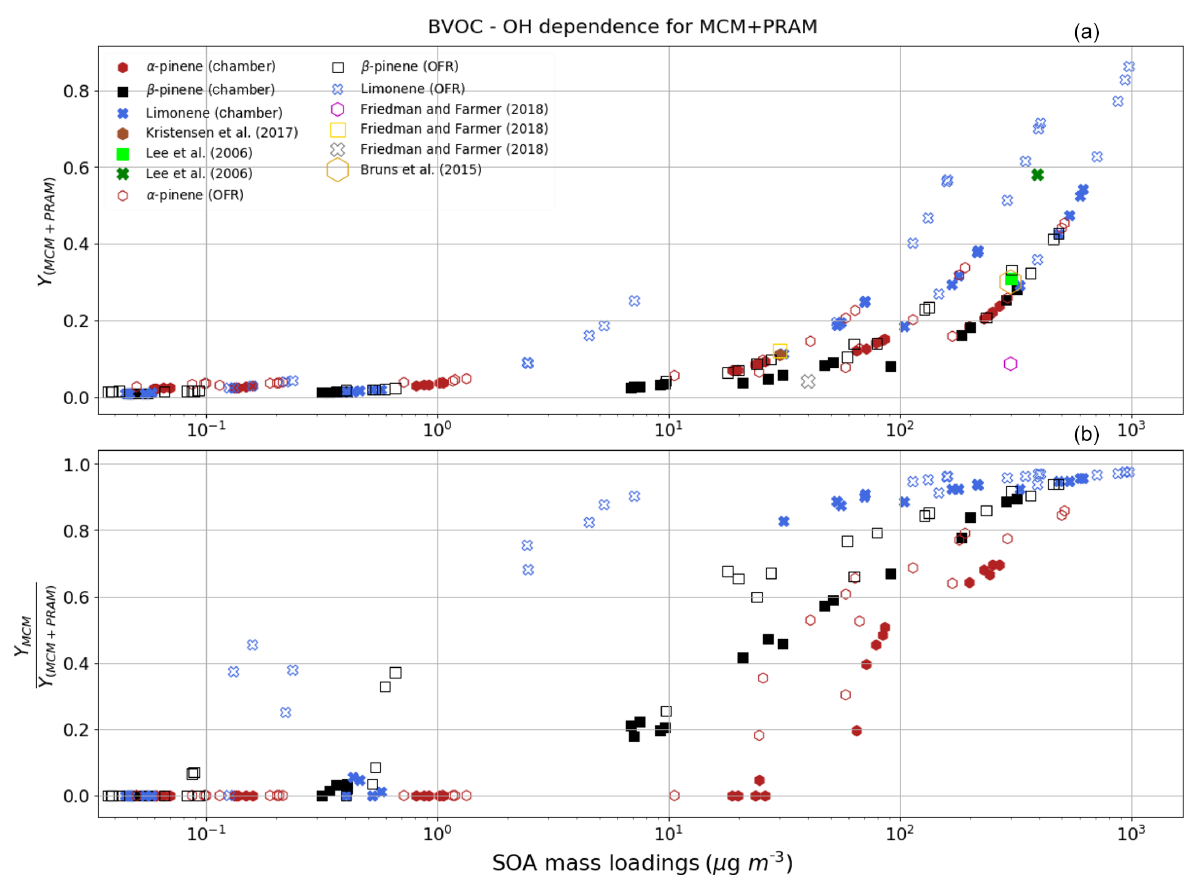
Figure 3. The mass yields from OH oxidation of BVOCs α -pinene (red heptagons), β -pinene (black squares) and limonene (blue crosses) modeled after chamber (filled symbols) and flow-tube settings (open symbols). The figure shows a comparison of SOA mass yields obtained from application of MCM + PRAM (a) and ratio of yields from MCM and coupled MCM + PRAM (b) . Currently PRAM is available for OH oxidation of limonene, α -pinene and β -pinene. Table 3. Mass yields for OH oxidation of BVOCs at 293K for different ranges of mass loadings using a chamber a and OFR b setup. SOA mass